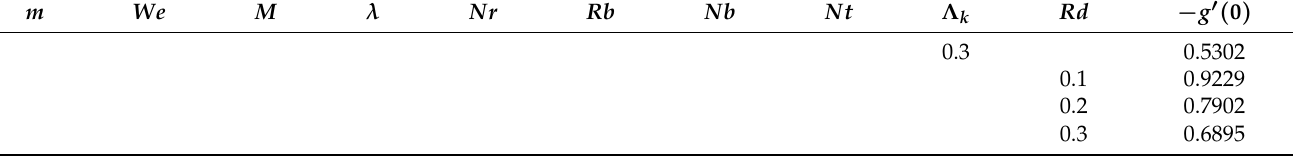
(cid:18)(cid:113) (cid:19) n + 1 ( − h (cid:48) ( 0 )) . 2